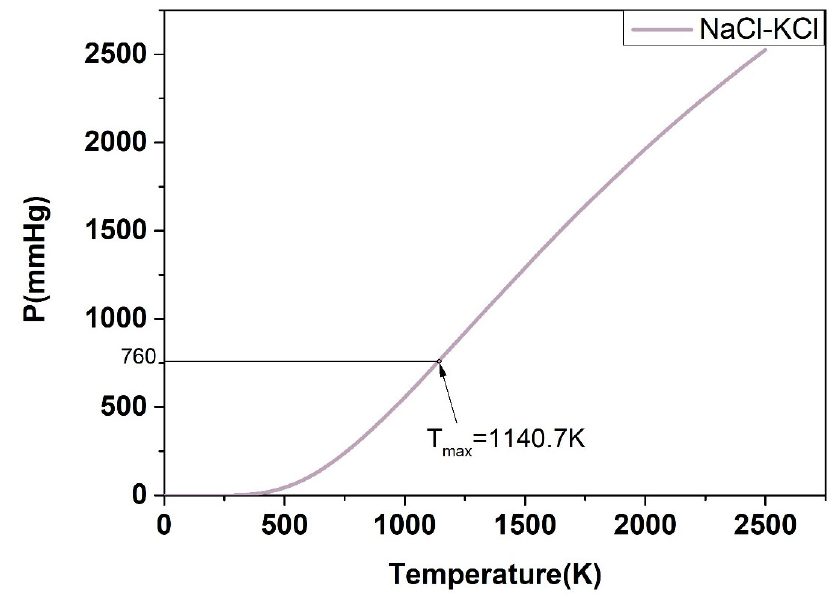
Figure 17. Calculated P-T phase diagram of the NaCl-KCl binary system.